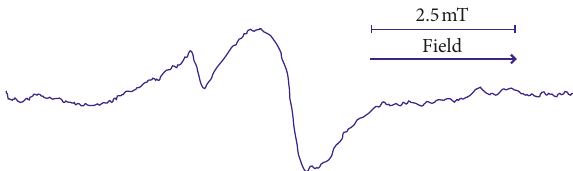
Figure 6: ESR spectrum of probe 1 in the erythrocyte suspension (control